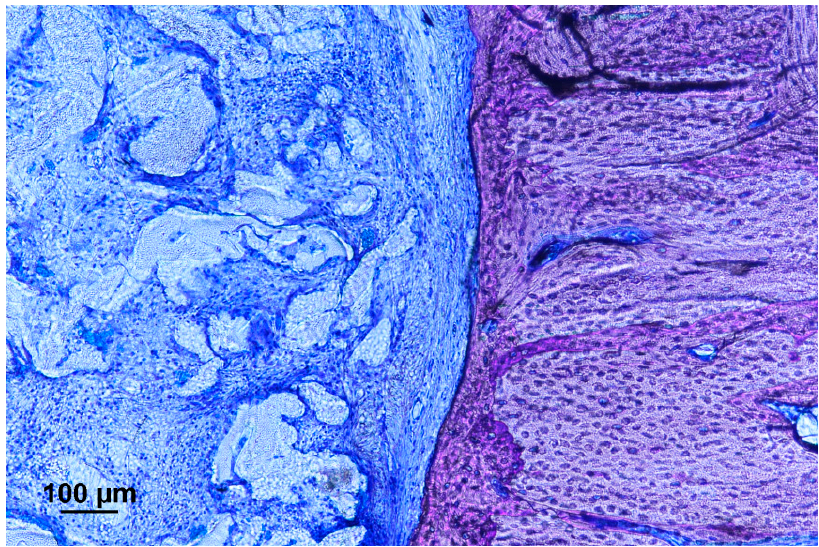
Figure 15. Histological staining in location next to segmental end of the critical-sized defect implanted with a polyurethane scaffold (Giemsa). There is no bone penetration into the scaffold, with the formation of a layer of fibrous tissue around the scaffold.